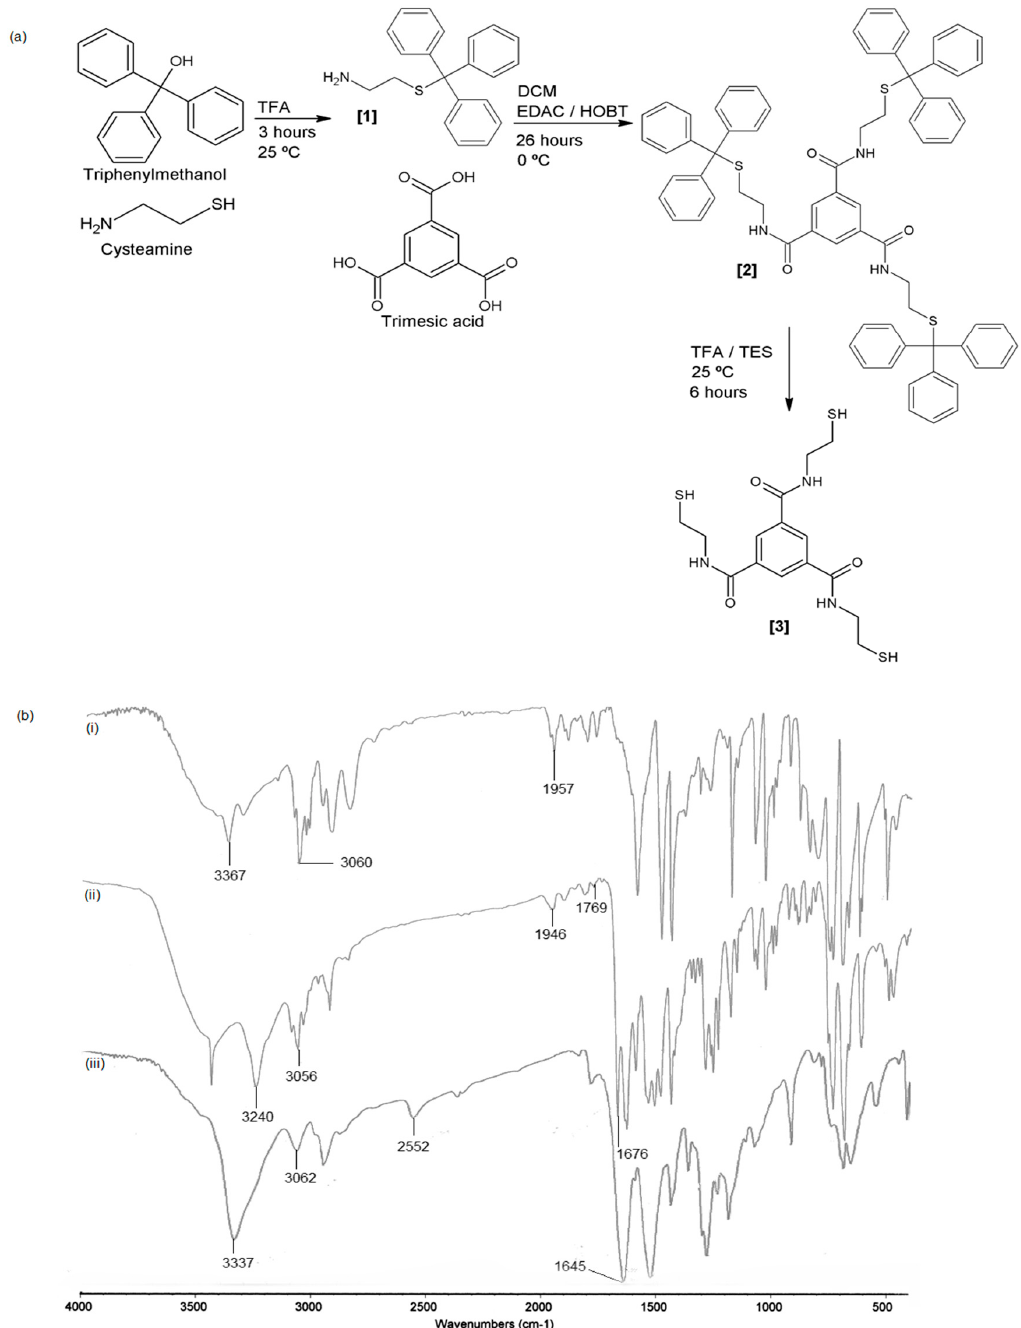
Figure 1. ( a ) Synthetic routes for preparation of the thiolated monomer; ( b ) FTIR spectra of ( i ) (triphenylmethyl)thioethylamine, ( ii ) N 1 ,N 3 ,N 5 -tris(2-(Tritylthio)ethyl)benzene-1,3,5-tricarboxamide, (triphenylmethyl)thioethylamine, ( ii ) N 1 ,N 3 ,N 5